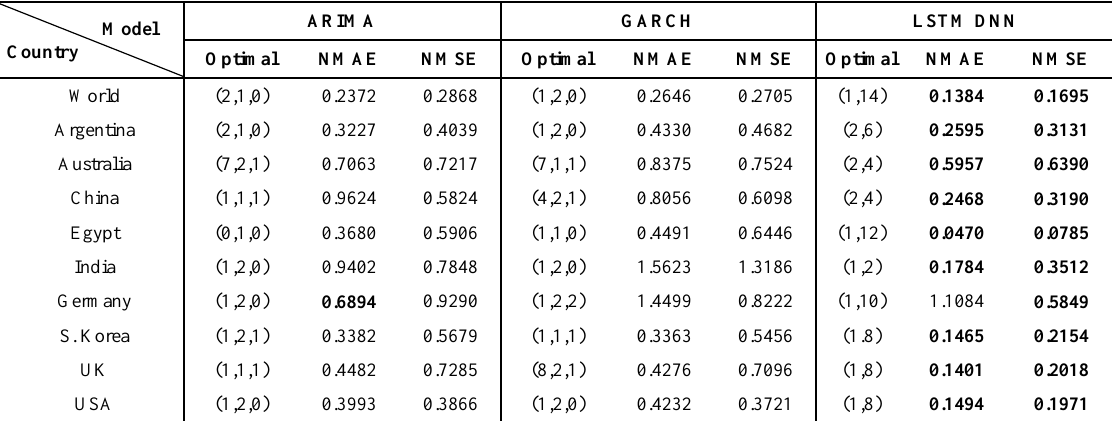
Table 2. Comparison of best NMAE and NMSE with optimal parameters ( r =